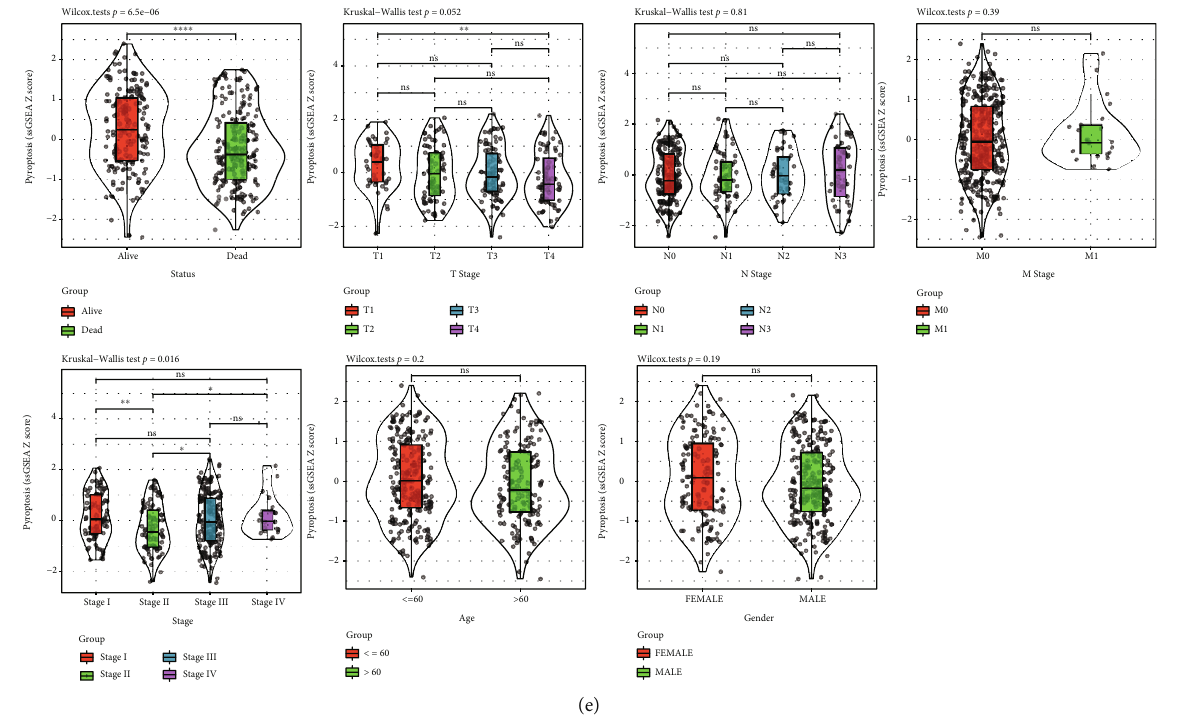
Figure 2: Establishment of pyroptosis-associated pro fi les among SKCM cases as well as the relation with additional clinical variables and prognostic outcome. (a) Correlation analysis between the scores of pyroptosis-associated pro fi les and clinicopathological features of melanoma patients in TCGA-SKCM cohort. (b, c) Univariate (b) and multivariate (c) Cox regressions were used to analyze the independent prognostic factors for melanoma. (d) KM analysis between samples with high and low scores of pyroptosis-associated pro fi les. (e) The di ff erence in scores of pyroptosis-associated pro fi les between di ff erent clinicopathological feature